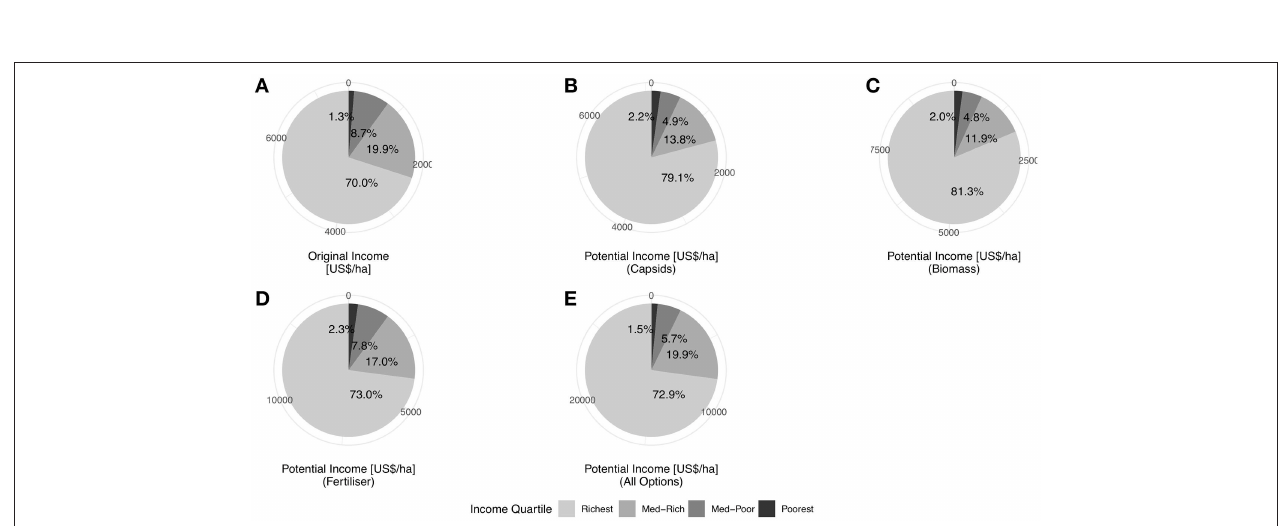
FIGURE 4 | Estimated distribution of income across quartiles. By summing total income and potential incomes across monitored farms, we estimated the proportion of income for each cocoa income quartile. (A) Presents current reported distribution of income, (B) distribution of increased incomes due to capsid management, (C) distribution of increased incomes due to changes in rotting biomass management, (D) distribution of increased incomes due to greater fertilizer application, and (E) distribution of increased incomes if all options are adopted.